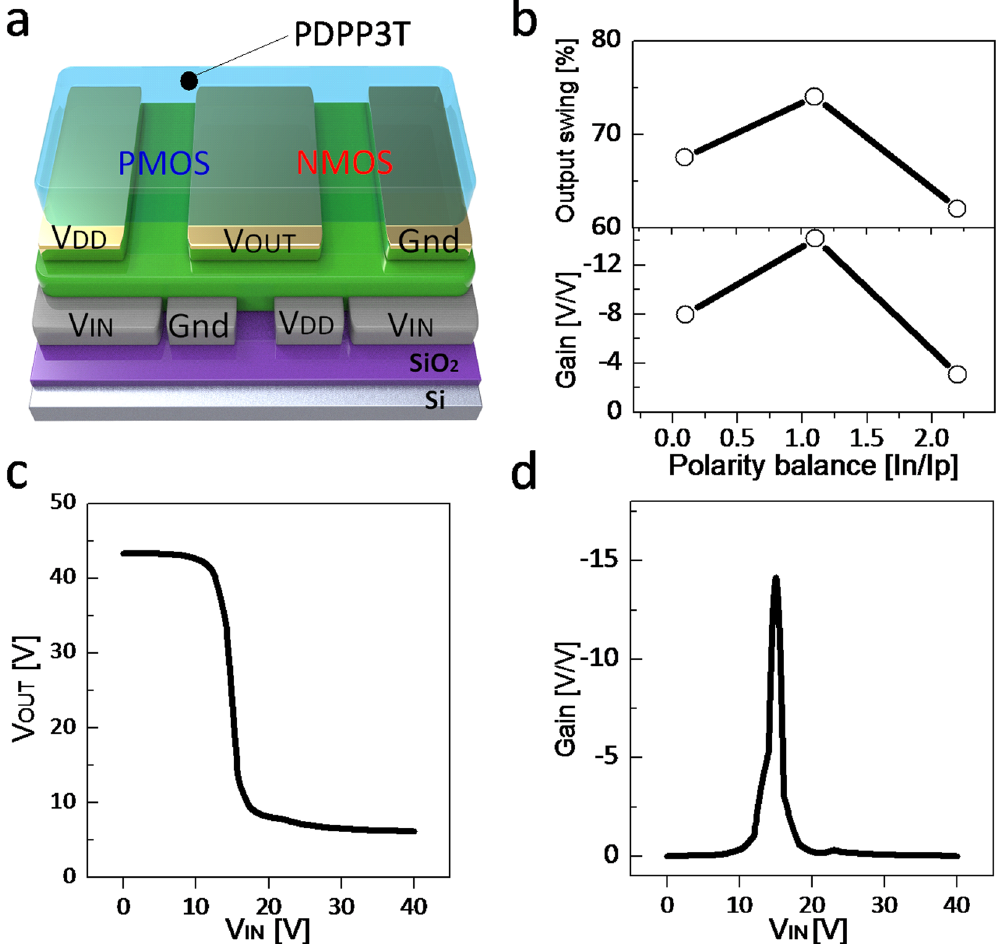
Figure 9. Impact of the polarity balance on the inverter performance. ( a ) Schematic of complementary split- gate PDPP3T inverter structure. ( b ) Output swing and gain as a function of the polarity balance. ( c ) Measured inverter characteristics (V OUT vs. V IN ) at the optimal condition of T III = 180 °C. ( d ) Gain ( = dV OUT /dV IN ) at T III = 180